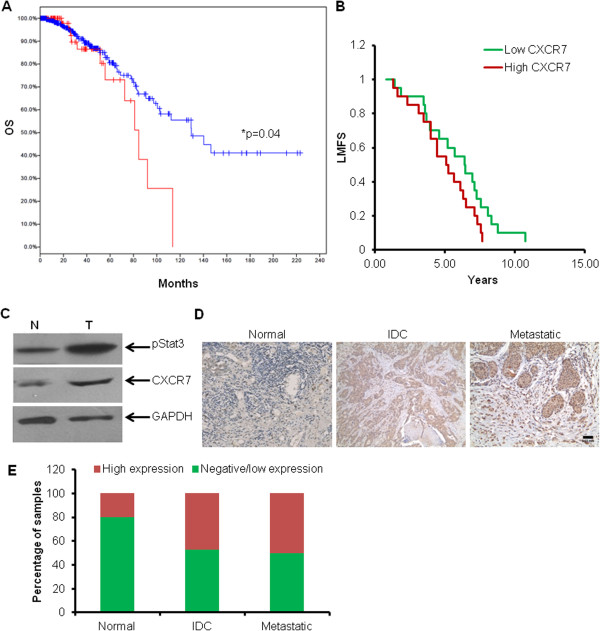
CXCR7 expression in human breast tumors correlates with worse patient outcome and CXCR7 and STAT3 expression in breast cancer patients. (A) Overall survival (OS) of TCGA IDC patients with or without ackr3 overexpression (greater than 1.0-fold SD above mean). (B) Lung metastasis-free survival (LMFS) of IDC patients from study GSE2603. LMFS was compared between 20 high-CXCR7- and 20 low-CXCR7-expressing patients. (C) Breast tumors and adjacent normal tissue (n = 4) were lysed with RIPA buffer, and the lysates were analyzed with Western blotting by using specific antibodies against p-STAT3 (86 kDa), CXCR7 (52 kDa), and GAPDH (37 kDa) as loading control. (D, E) Representative tissue microarray cores of normal and cancerous breast tissue (20×, scale bar, 0.03 mm). Tissue microarray (TMA) samples containing 10 normal, 10 metastatic, and 38 invasive ductal carcinomas (IDCs) were analyzed with immunohistochemistry by using CXCR7 antibodies (kindly provided by ChemoCentryx).